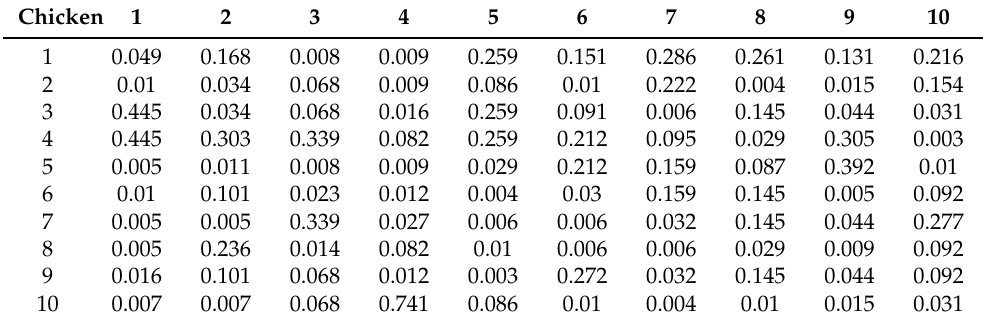
Table A7. Normalization matrix of chicken.